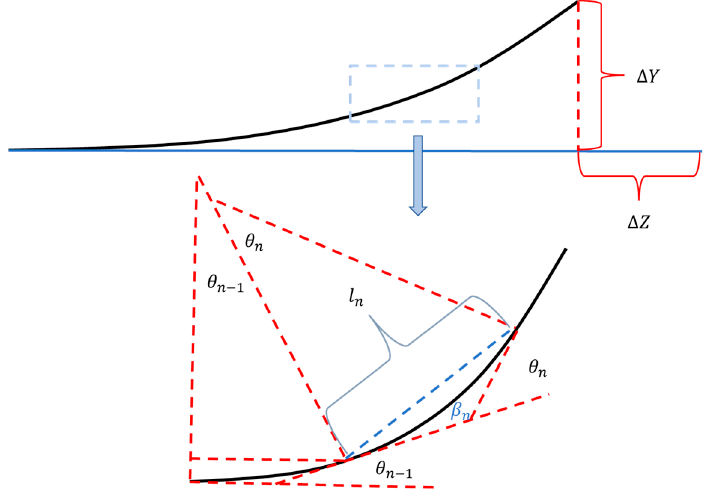
Figure 10. Differential method for determination of Y-deformation of the supporting beam. The out-of-plane deformed beam was discretized into multiple segments shown in the amplification area of the blue dashed box.